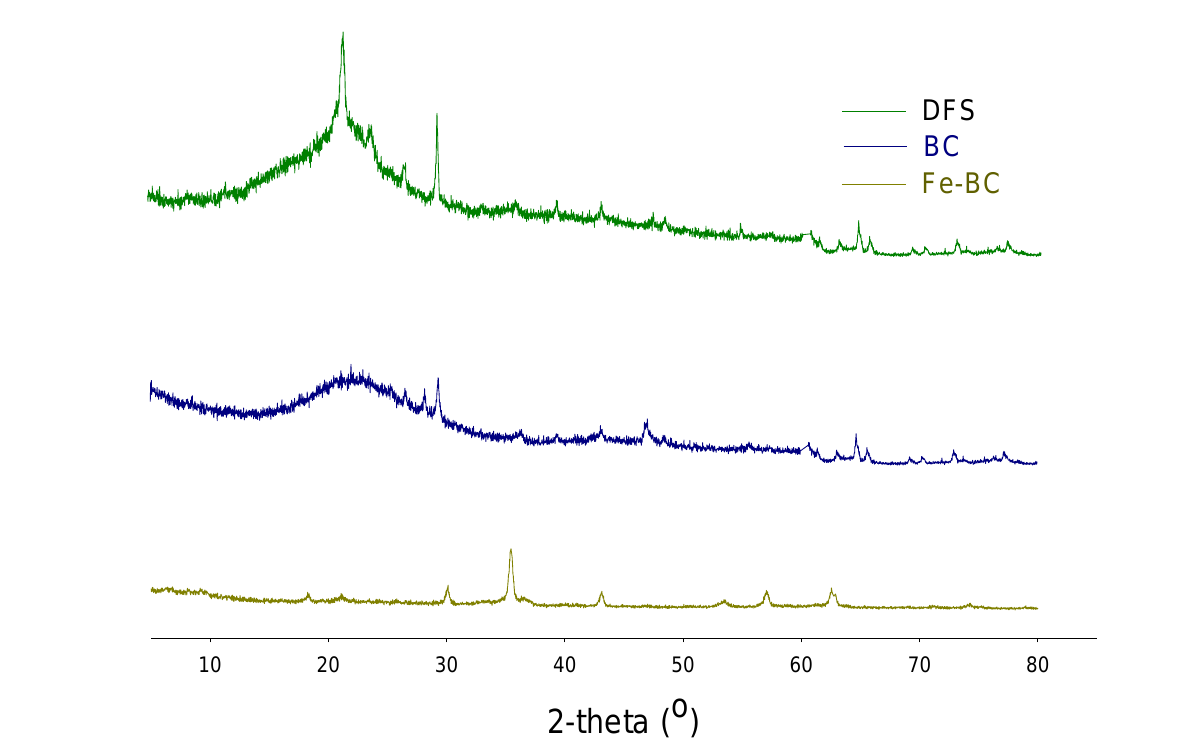
Figure 1. FTIR analysis of date palm waste (DFS), date palm waste biochar (BC), and Fe-modified biochar (Fe-BC).